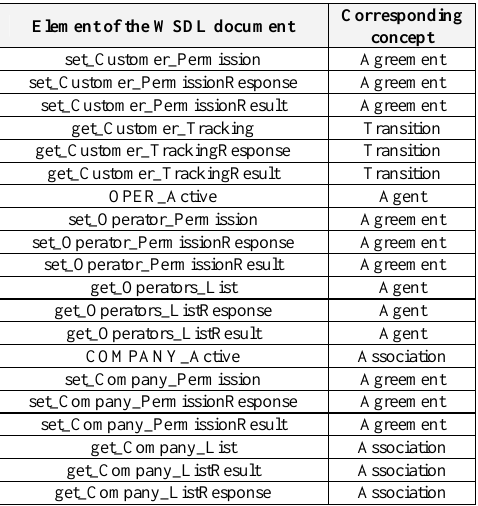
Table 3. Manual associations Element of the WSDL document